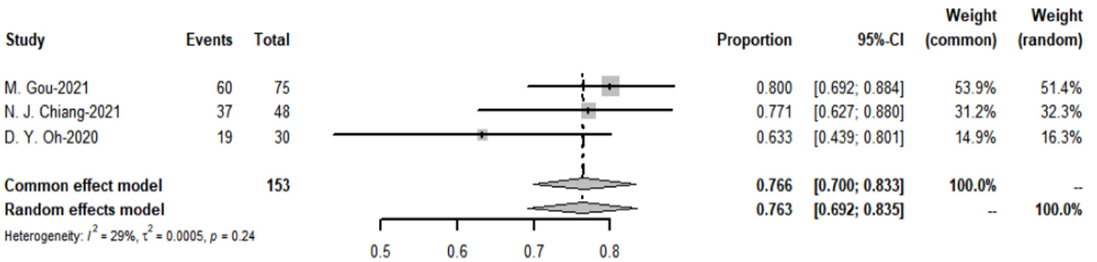
Figure 14. Progression ‐ free survival in the targeted chemotherapy combination group compared with the chemotherapy alone group. Figure 20. Disease control rate of targeted therapies and funnel plot.